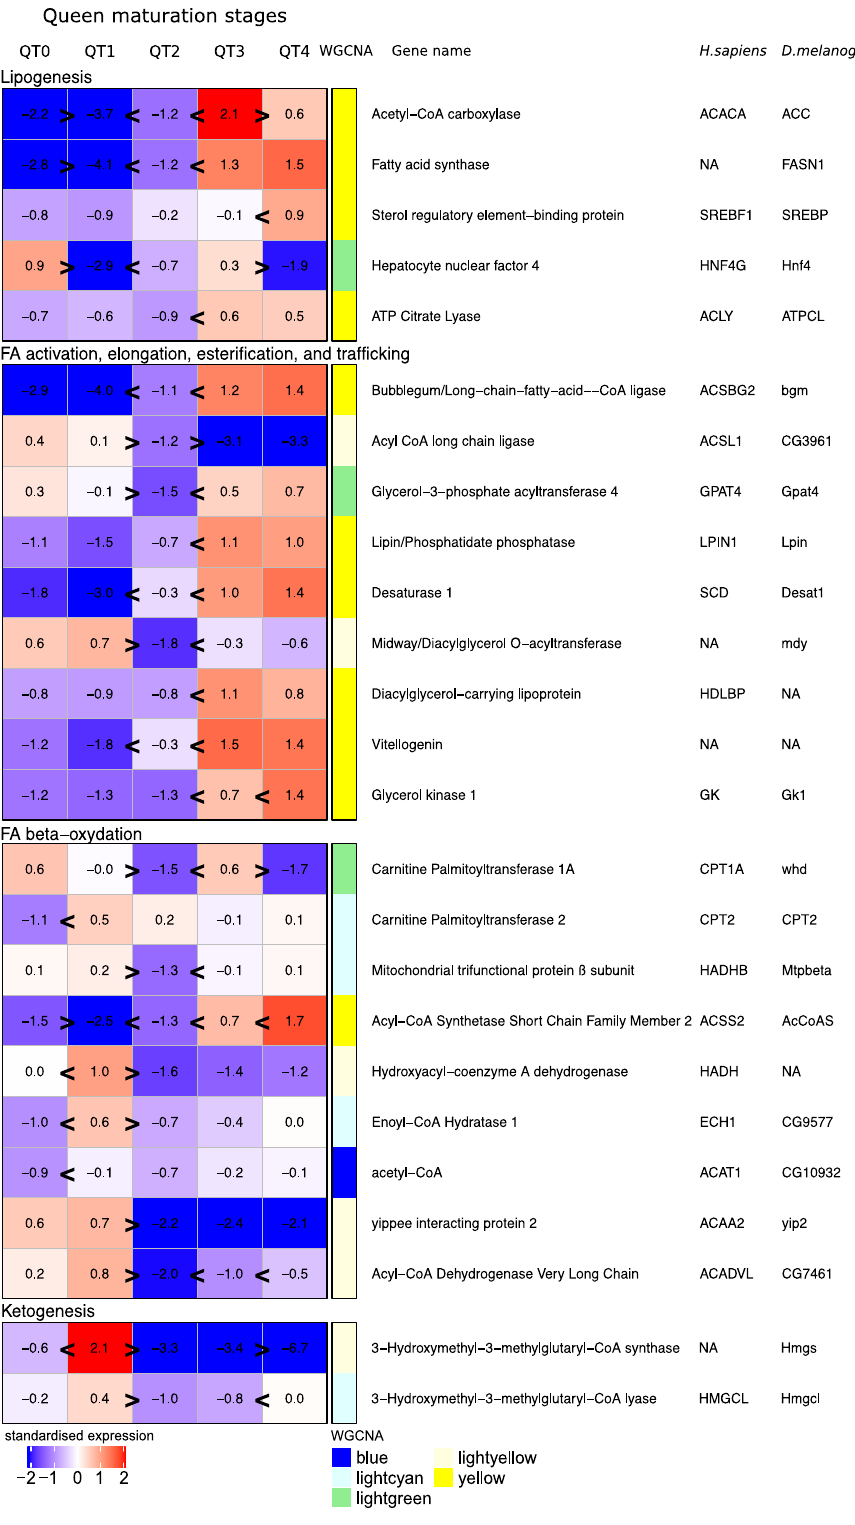
Fig. 5 Heatmap with the expression of genes in fat bodies during adult queen maturation involved in lipid metabolism. Heatmap representing standardized gene expression (blue = low; red = high) at each of the fi ve queen stages (QT0 – QT4). Annotations to the right of the heatmap include the WGCN module (Supplementary Fig. 2), gene name, and gene acronyms in Drosophila melanogaster ( D. melanogaster ) and Homo sapiens ( H. sapiens ). The number of replicates per group is provided in Supplementary Table 1. Greater than or less than symbols (>/<) represent signi fi cant differences in